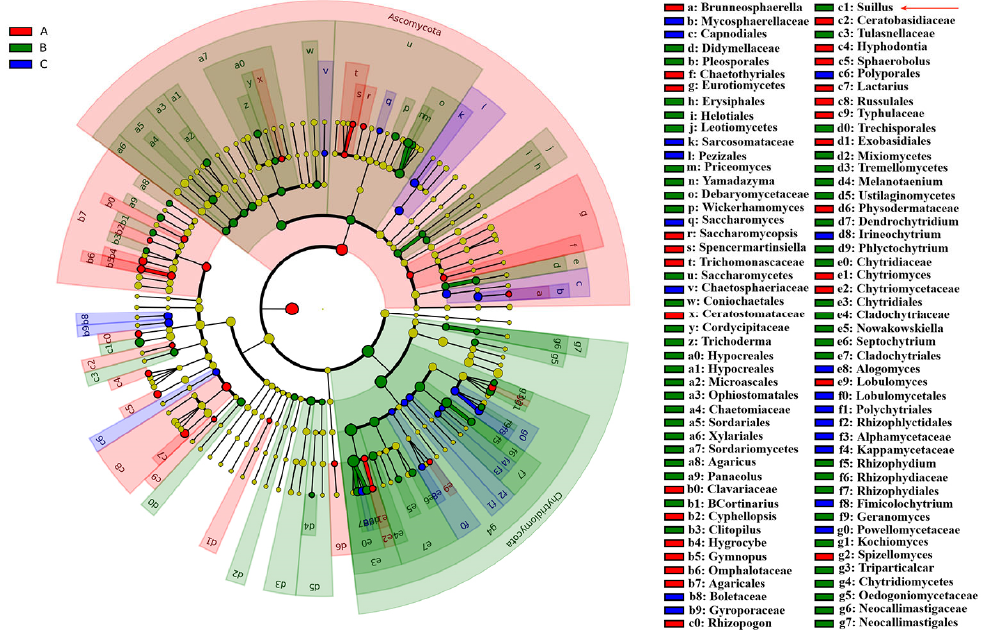
Figure 5. LEfSe identified the most differentially abundant taxon among soil with ectomycorrhizal- fungus inoculation (WE), soil without ectomycorrhizal–fungus inoculation (NE), and bulk soil (BS); the hierarchical relationship of all taxa from phylum to genus (inner to outer circle) in the sample community is shown, node size corresponds to average relative abundance of the taxon, and colored shadows refer to trends of significantly differed taxa. Arrows indicate position of Suillus .